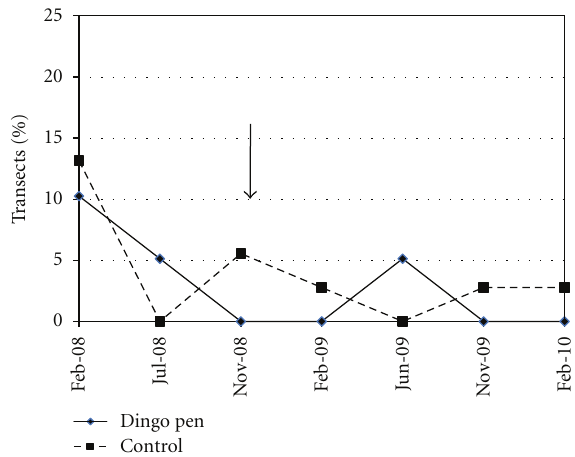
Figure 4: The percentage of transects (Dingo Pen n = 29, control n = 38) with fox tracks recorded at sites within the Dingo Pen and control area. Foxes were released into the Dingo Pen between June and October 2009 and into the control area between October and December 2009. The pen was completed in November 2008 and the arrow indicates when dingoes were released.